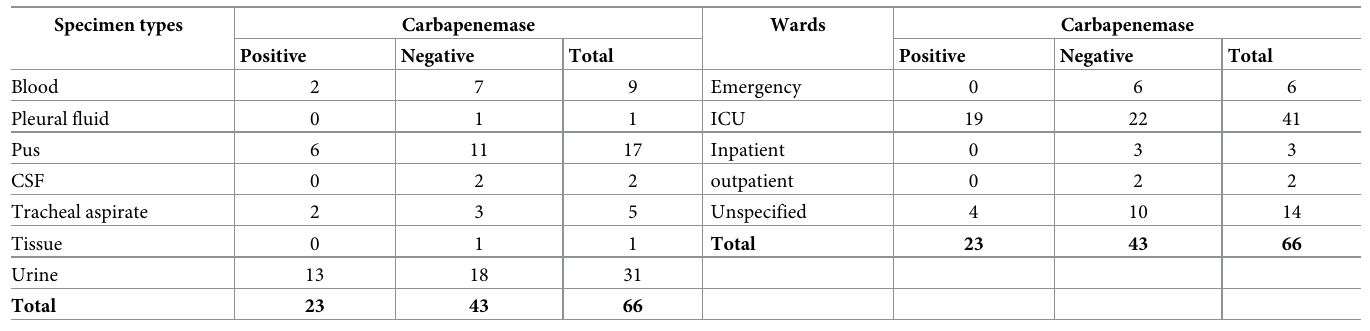
Table 4. Distribution of carbapenemase among wards and specimen sources. Specimen